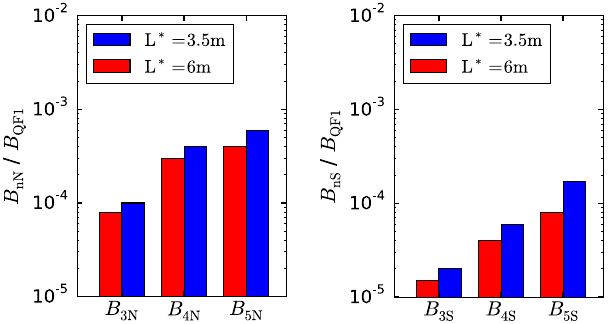
FIG. 13. Normal (left plot) and skew (right plot) sextupole, octupole, and decapole field error tolerances for